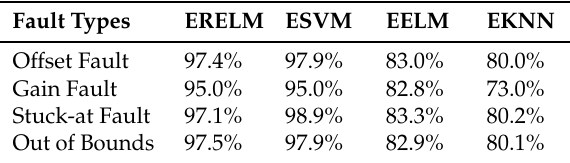
Table 5. DA with 30% induced faults.